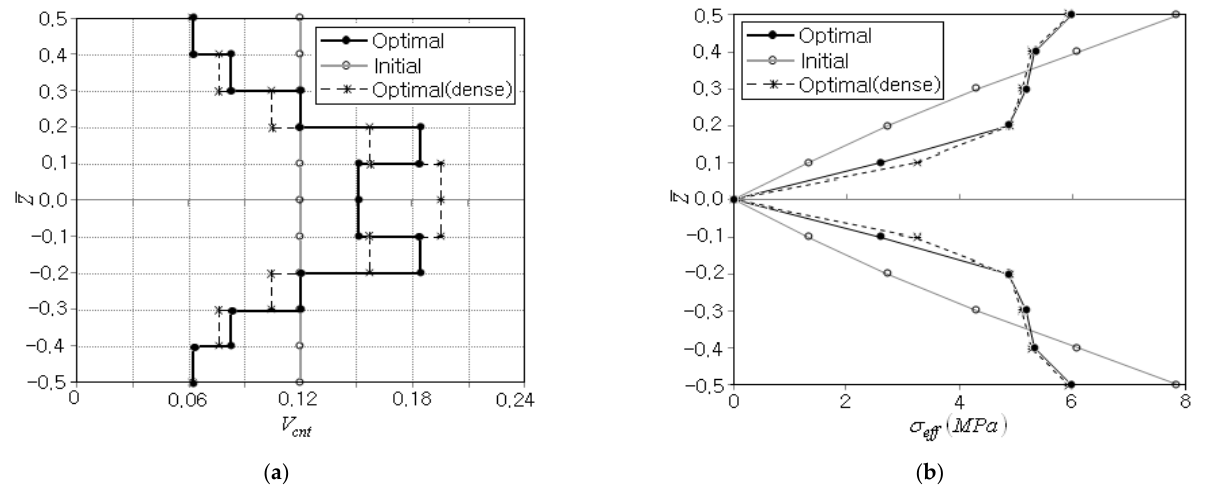
Figure 6. Comparison of initial and final distributions through the thickness: ( a ) the CNT volume fraction V ∗ cnt , ( b ) the effective stress σ ef f .